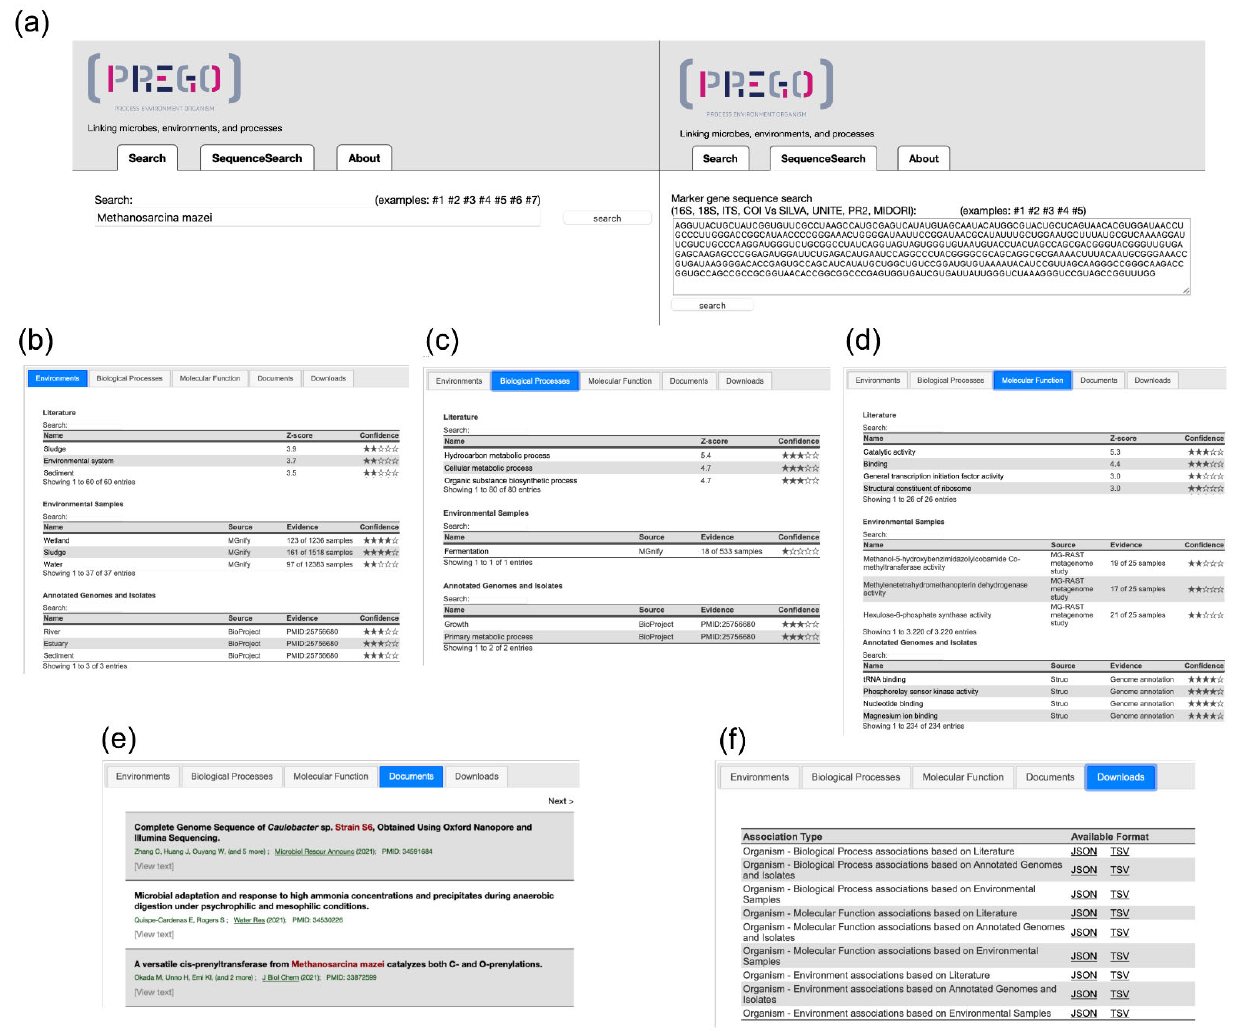
Figure 2. PREGO web user interface: ( a ) There are two search fields for user queries, plain text, and taxa sequences. ( b – d ) For the selected query, three association tabs are provided, each one presenting associations of the queried entity with the respective entities, Environments ( b ), Biological Process ( c ), and Molecular Function ( d ). Three channels of information distinguish the associations based on the original data. ( e ) The Documents tab presents the scientific articles that mention the queried entity with a highlighted color. ( f ) The Downloads tab provides the associations of each channel (when available) for download in JSON and TSV format.